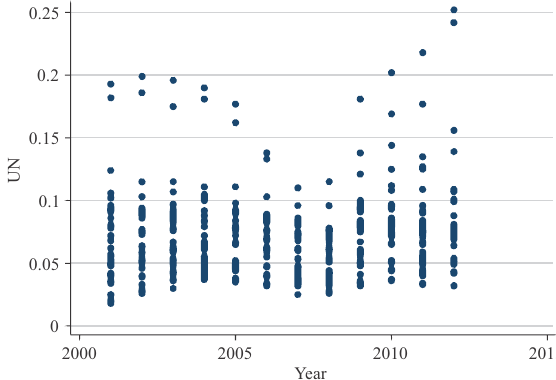
Fig. 1. Plot of unemployment rates for countries 3 in the study Note: The unemployment rate (UN) for all of the countries is measured as a